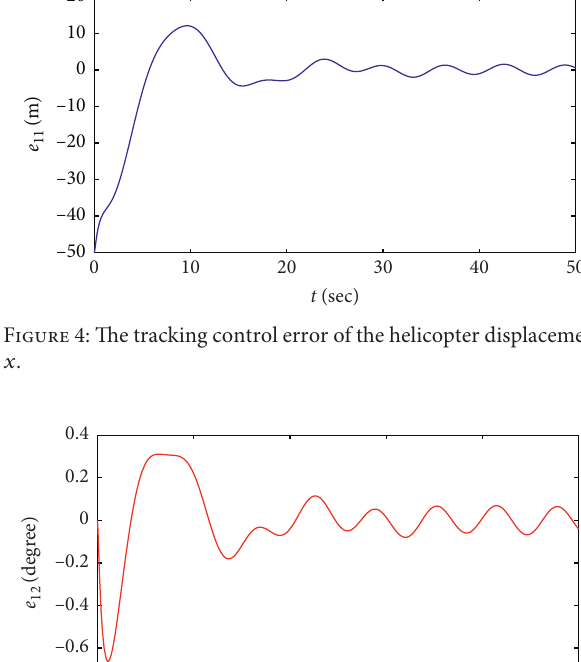
Table 1: System parameters.